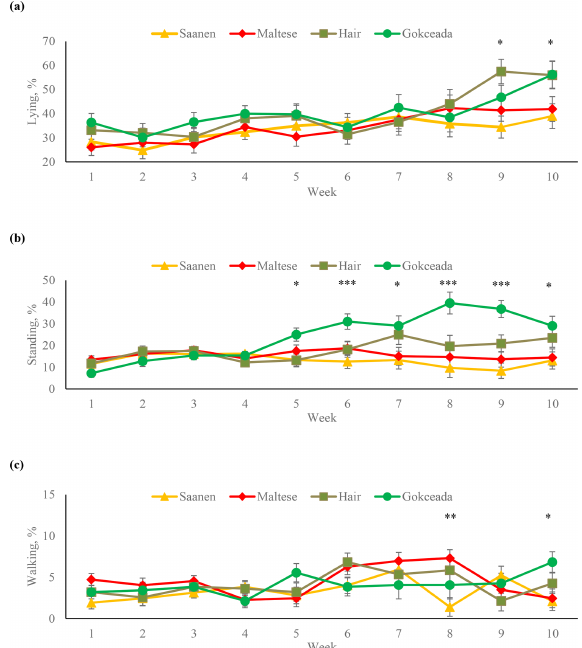
Figure 1. Percentages of (a) lying, (b) standing and (c) walking behaviours at different fattening weeks according to breed. ∗ P < 0 . 05. ∗∗ P < 0 . 01. ∗∗∗ P < 0 .